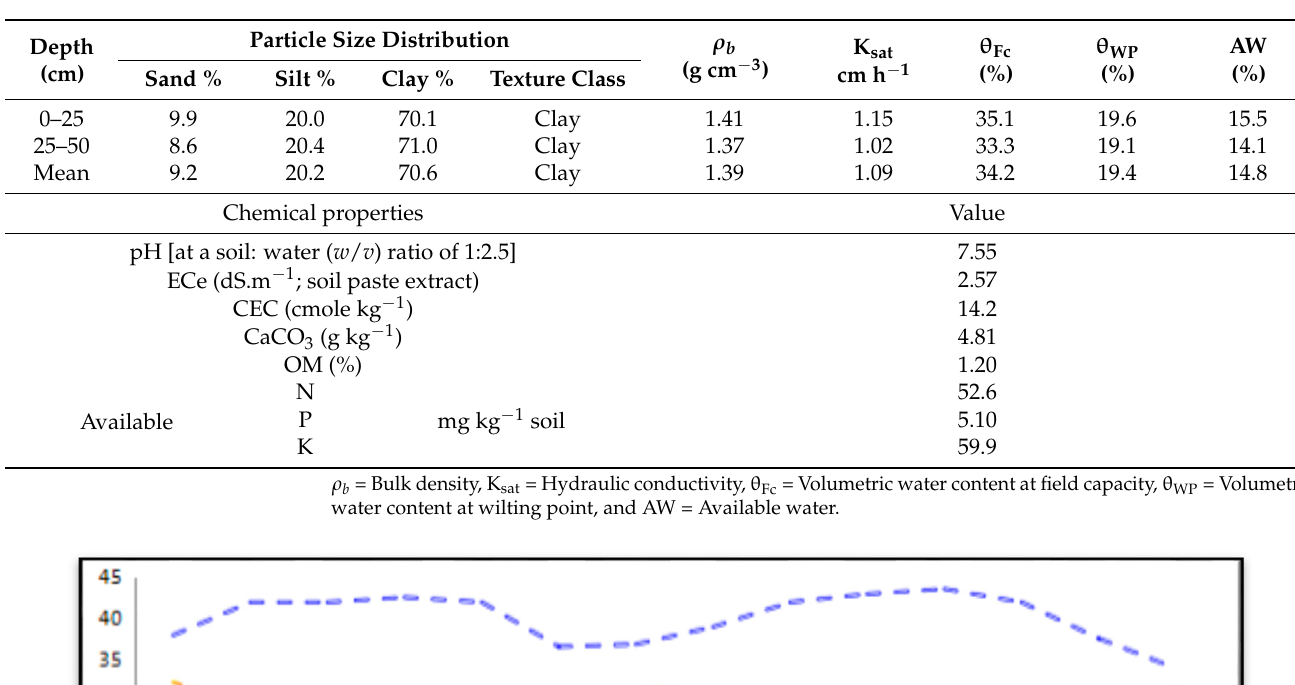
Table 1. The main physical and chemical properties of the soil used for experiments.